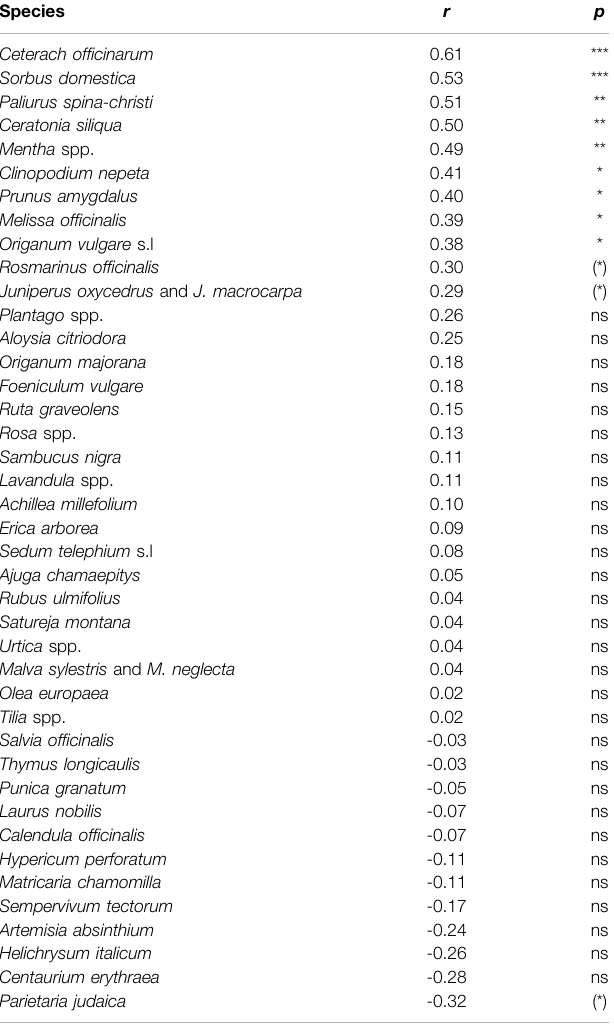
TABLE 4 | Correlation between the island ’ s geographical longitude and the species frequency (on a scale of 0 – 1) on particular islands. Species